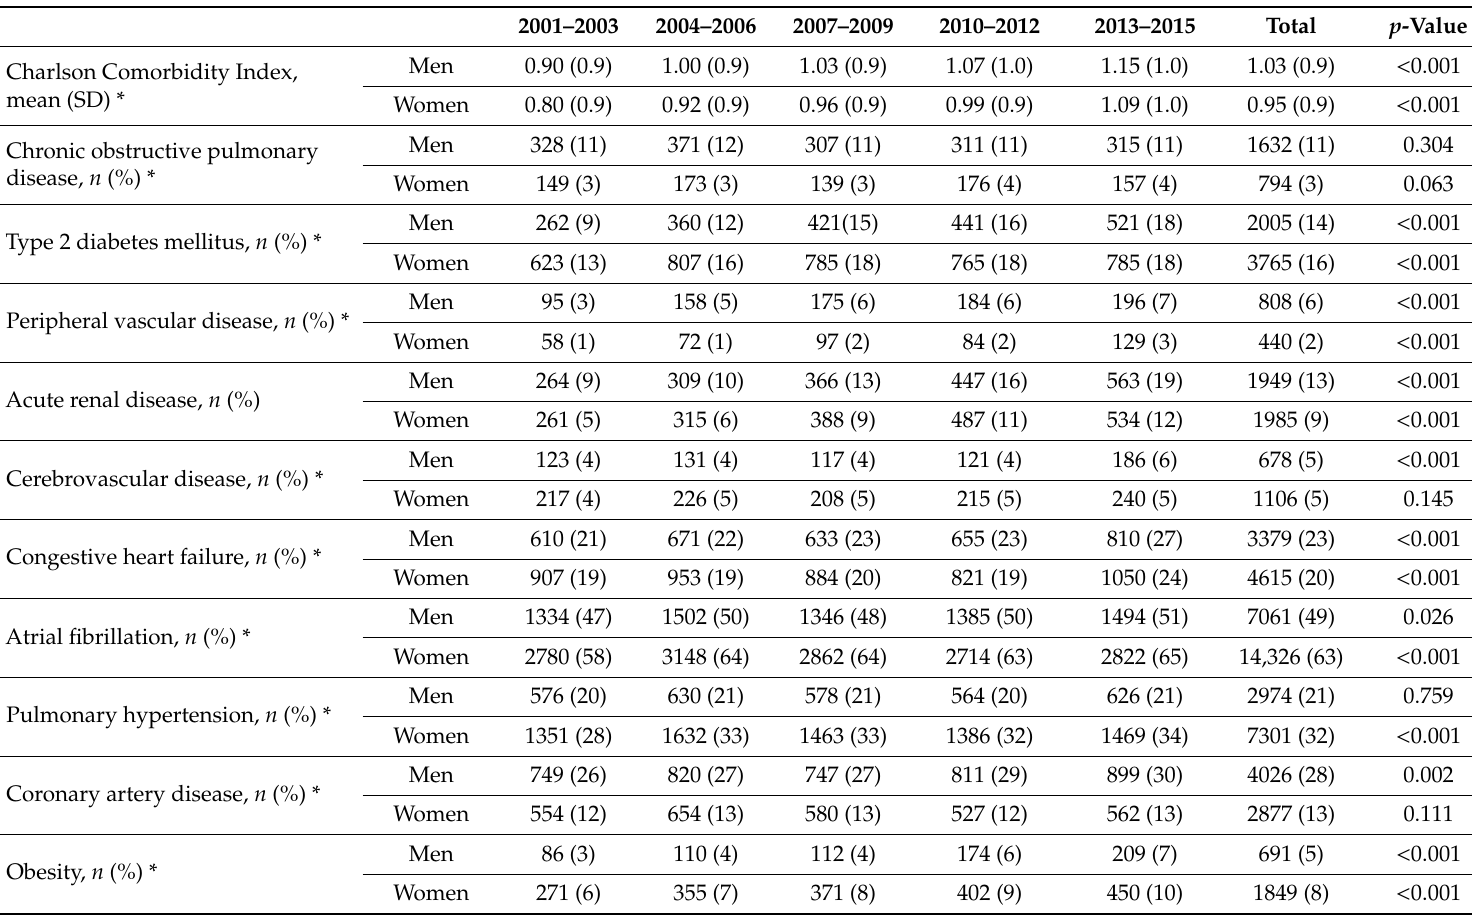
Table 1. Comorbid conditions in hospitalized patients undergoing mechanical mitral valve replacement in Spain from 2001 to